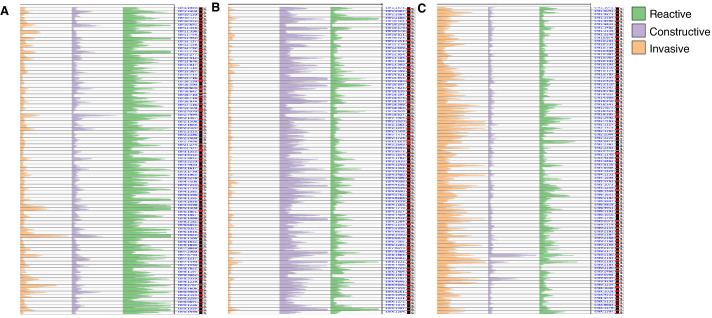
Distinct chromatin accessibility profiles across glioblastoma stem cell states.(A–C) Overlaid ATAC signal tracks for the 27 GSCs at the 92 most differentially accessible regions between GSC states as determined by pairwise Wilcoxon test and a median signal fold change equal or greater than 2. The region coordinates can be found in the Supplementary file 2. (A) Most accessible in Reactive state GSCs. (B) Most accessible in Constructive state GSCs. (C) Most accessible in Invasive state GSCs.